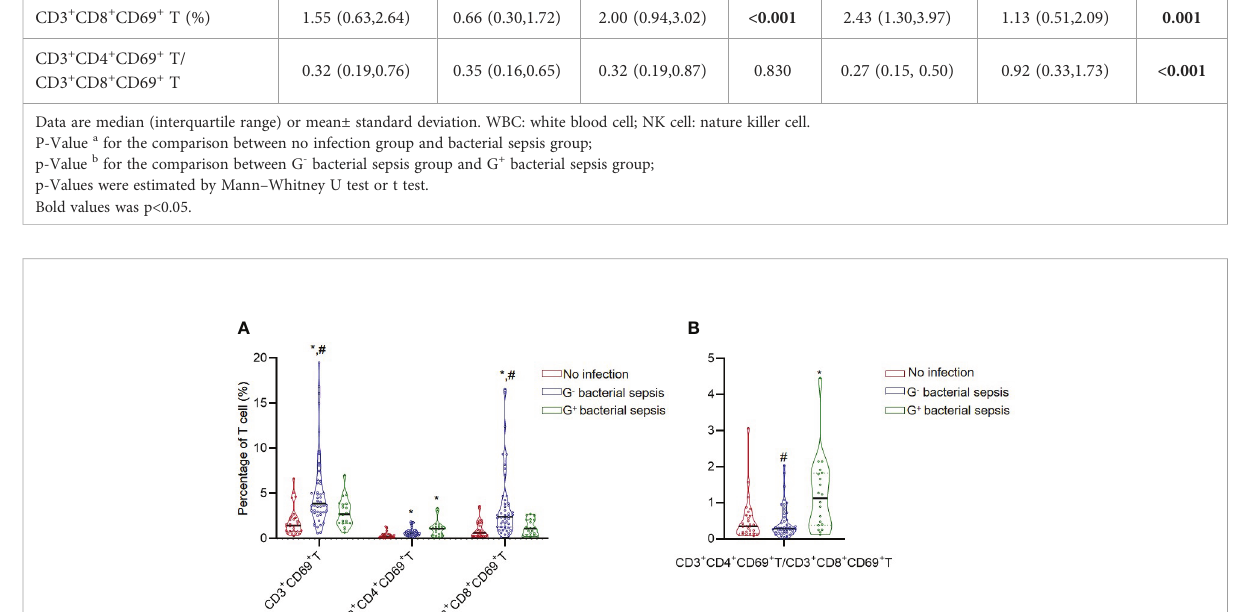
FIGURE 2 The CD3 + CD69 + T cell subset and CD3 + CD4 + CD69 + T/CD3 + CD8 + CD69 + T ratio in critically ill patients. (A) The percentages of CD3 + CD69 + T subsets in different groups. (B) The ratio of CD3 + CD4 + CD69 + T/CD3 + CD8 + CD69 + T in different groups. *, vs. no infection group; #, vs. G + bacterial sepsis group;